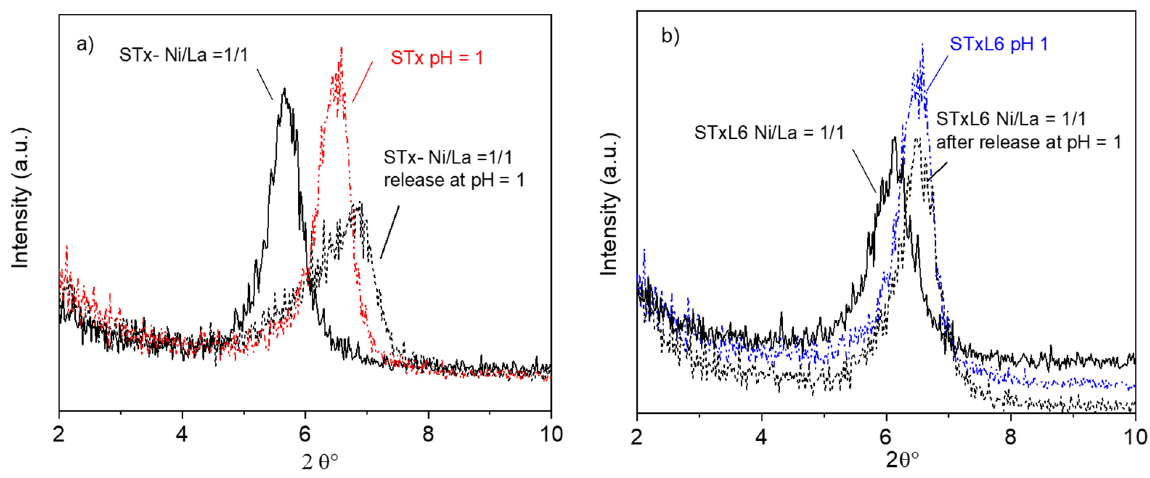
Figure 5. XRD patterns of sorbent solids after release for the mixed Ni/La systems: ( a ) pristine STx and ( b ) modified STxL6 (STx and STxL6 treated at pH = 1 and samples after the capture step are reported for comparison).